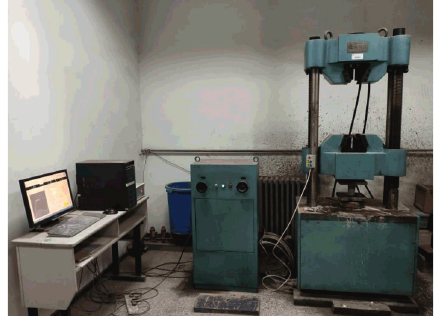
Figure 5: The uniaxial compression test bench.